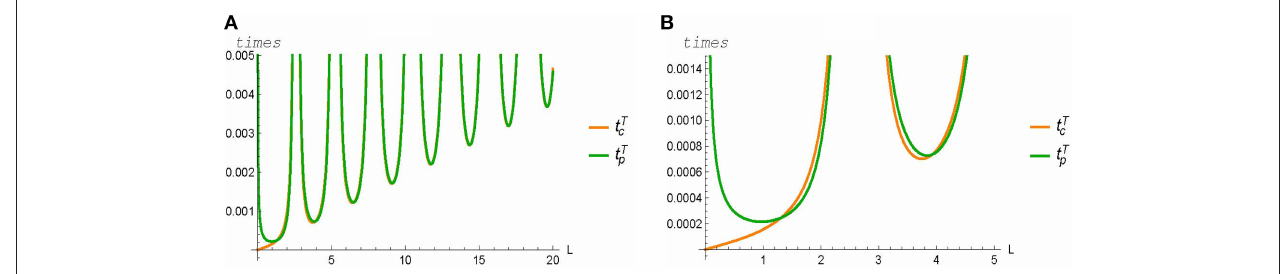
FIGURE 2 | (A) Tunneling times for an even arrangement of two δ (1) interactions, with γ parameters.